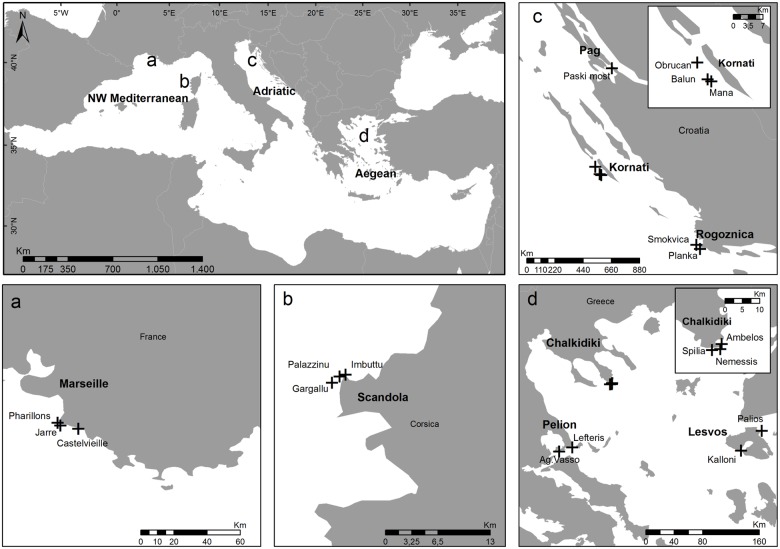
Map of the Mediterranean showing the investigated regions of the NW Mediterranean, CE Adriatic and N Aegean.Inset figures a—d present localities (in bold). Crosses mark the study sites of the yellow gorgonian Eunicella cavolini.